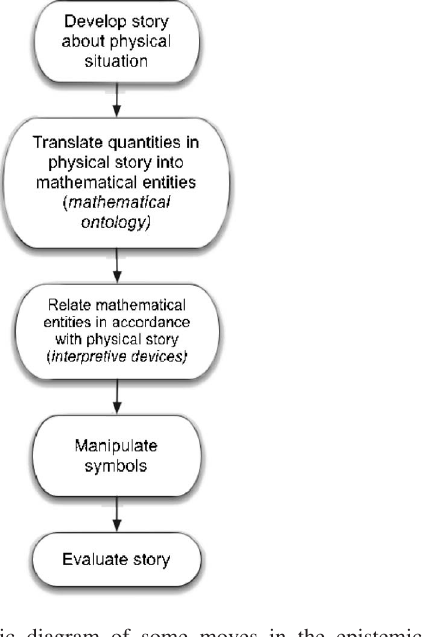
FIG. 1. Schematic diagram of some moves in the epistemic game Mapping Meaning to Mathematics.